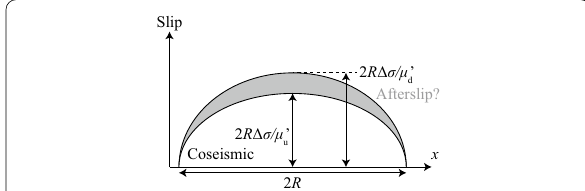
Fig. 1 Difference in the undrained and the drained responses for uniform stress drop �σ . Afterslip due to PE expected for an inplane shear crack with constant frictional strength is indicated in